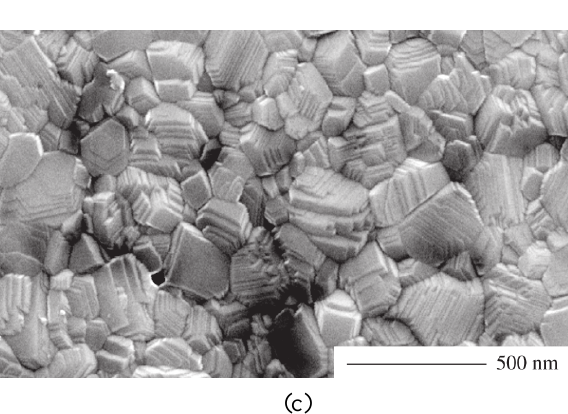
Figure 4. SEM Micrographs of: a) C03; b) C05; c) C07 at 1000 °C, with a CHR of 5 °C/min.